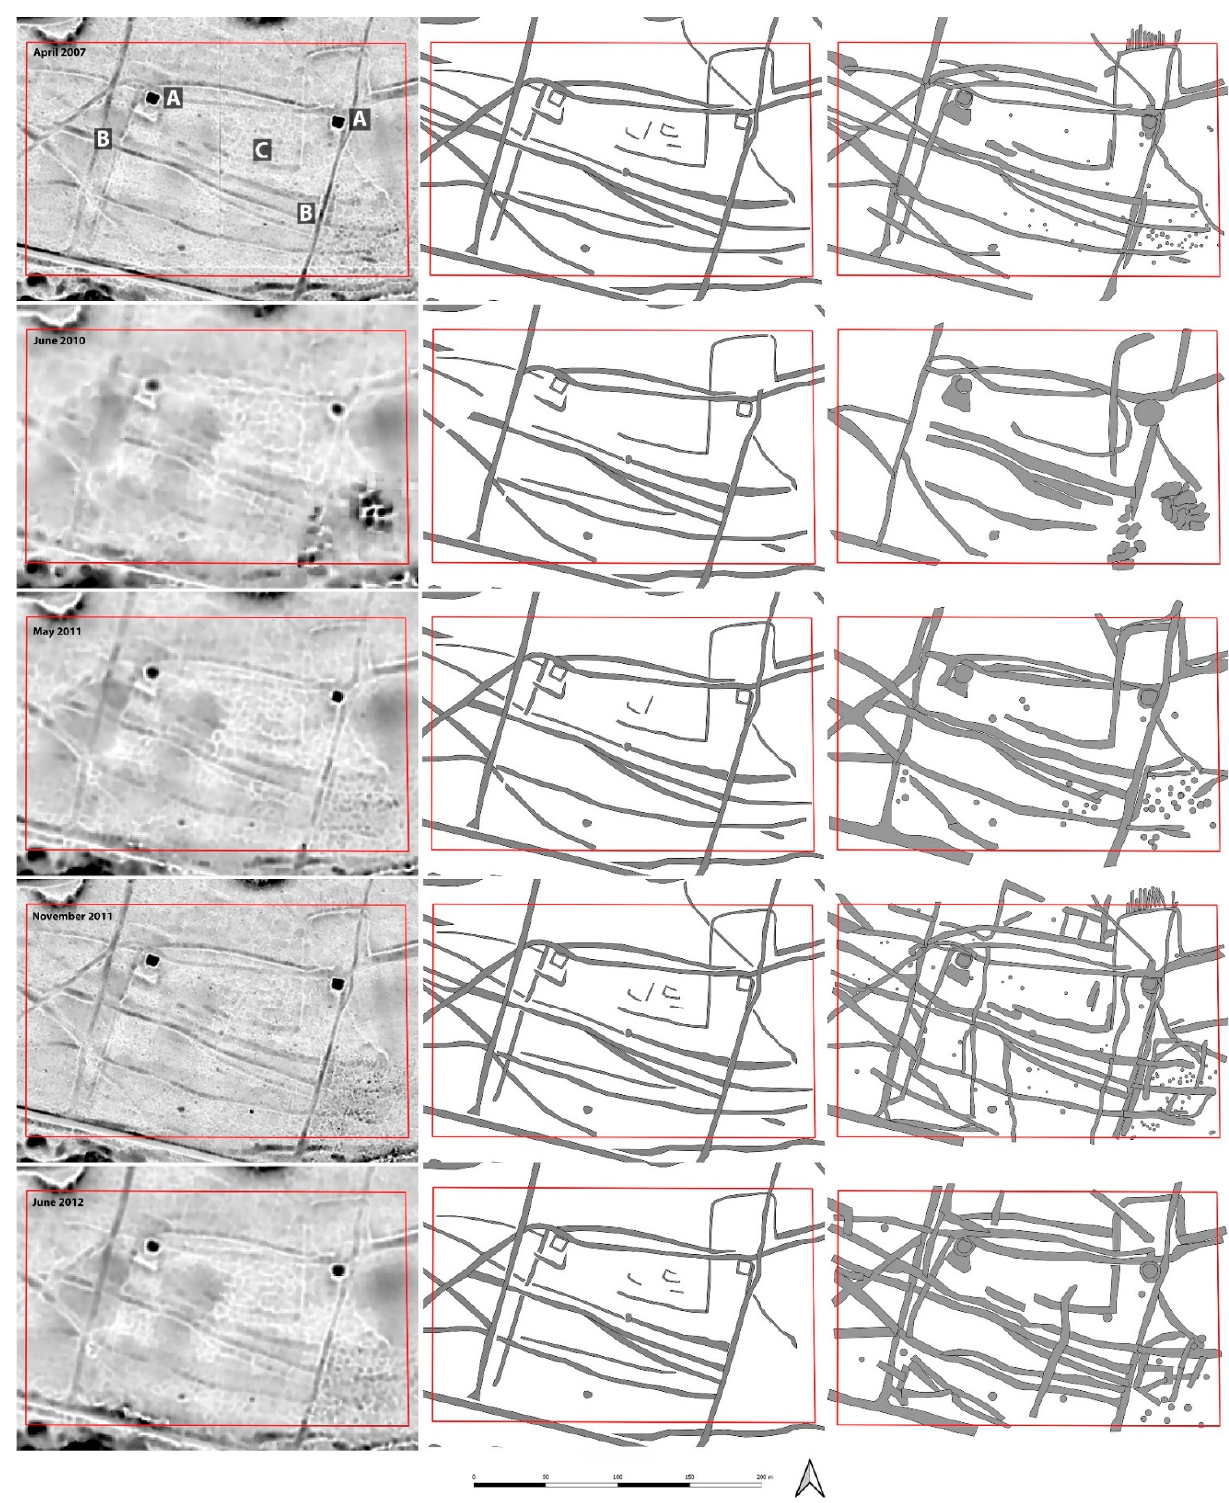
Figure 13. Area 2. The columns represent a visualisation of the dataset using positive openness with colour gradient black to white, stretch to min–max min. 1.41–max. 1.58 ( left ), results of the “copied interpretation” ( centre ), and results of the ”individual interpretation” ( right ). The rows correspond to the individual datasets as indicated for each row in the left image. The red box represents the boundary of the sample area. The letters in the upper left image refer to the text.